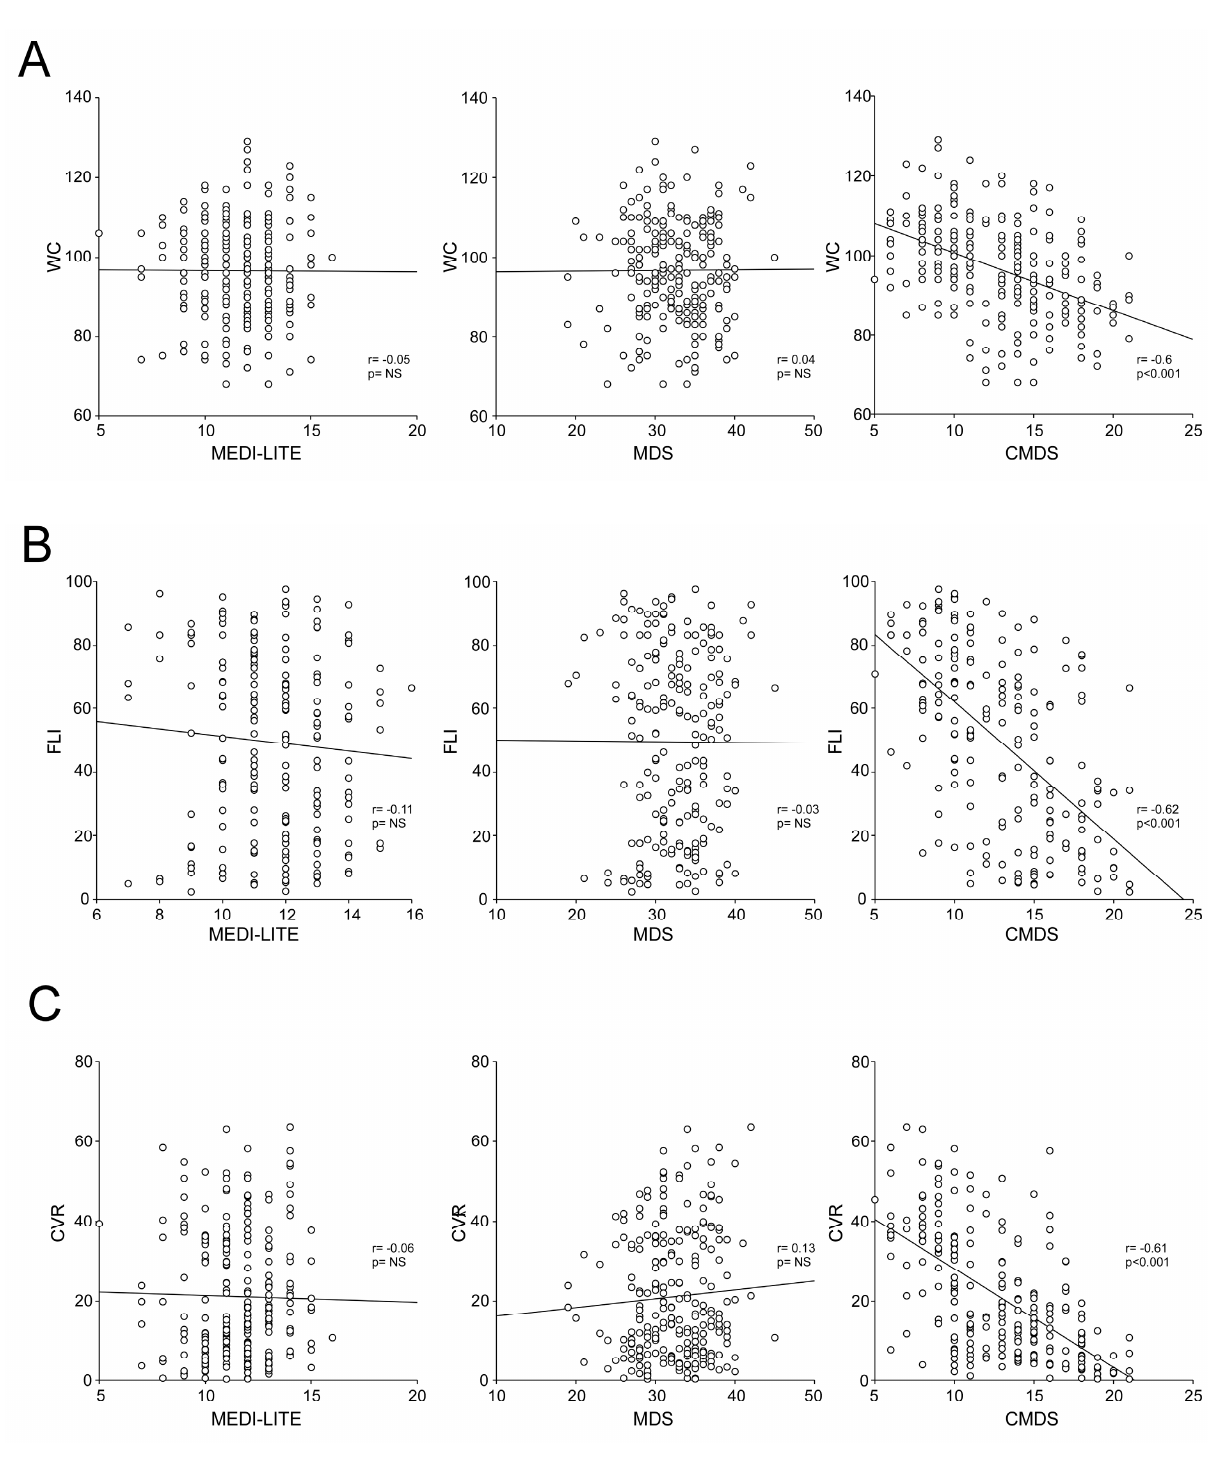
Figure 5. Correlation between Chrono Med Diet Score, MEDILITE score, and Med Diet Score with visceral adiposity, liver steatosis, and cardiovascular risk. The correlation analysis was estimated using Spearman Correlation Coefficient (r); ( p ) indicates statistical significance. Each dot represents a single subject. ( A ) Correlation analysis of waist circumference (WC) with MEDI-LITE, MDS, and CMDS. ( B ) Correlation analysis of Fatty Liver Index (FLI) with MEDI-LITE, MDS, and CMDS. ( C ) Correlation analysis of cardiovascular risk score (CVR) with MEDI-LITE, MDS, and CMDS.